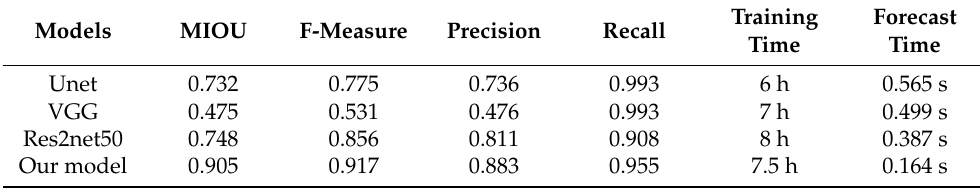
Table 2. Comparison of model